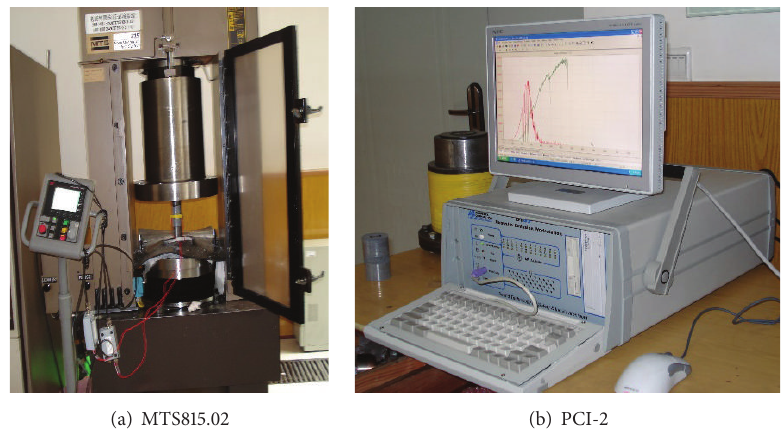
Figure 2: Appearance of MTS815.02 System and PCI-2 AE Detector.